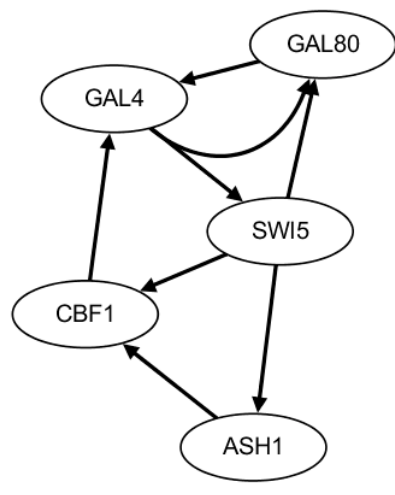
Figure 4. The standard IRMA network.